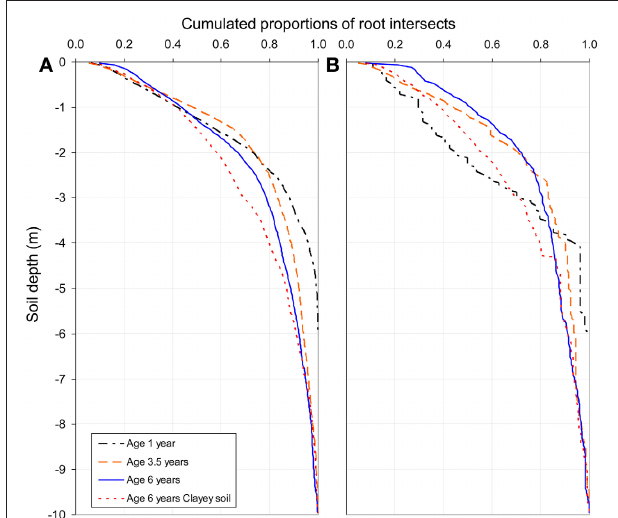
FIGURE 5 | Cumulative distribution of fine root intersects (diameter less than 1mm, A) and medium-sized roots intersects (diameter 1–3mm, B) down to a depth of 10m, from observations on 2–6 soil profiles at each stand age. Cumulative distribution of root intersects are not shown 2 years after planting because root intersects were only measured down to a depth of 6m although soil coring showed the presence of roots lower down (fine root densities below 6m were considered negligible at age 1